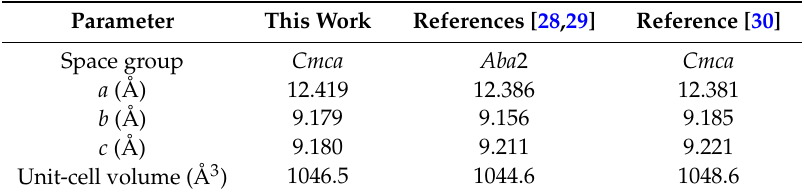
Table 1. Zr 7 Ni 10 unit-cell lattice